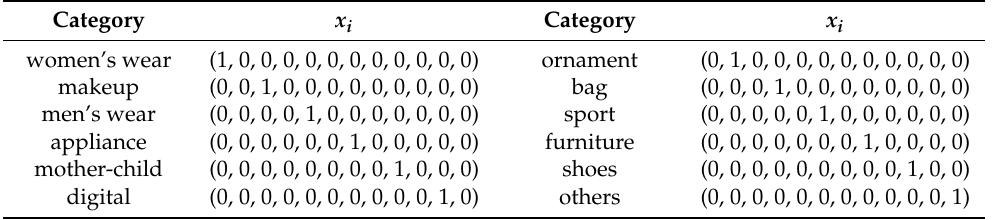
Table 2. Category one-hot encoding form.